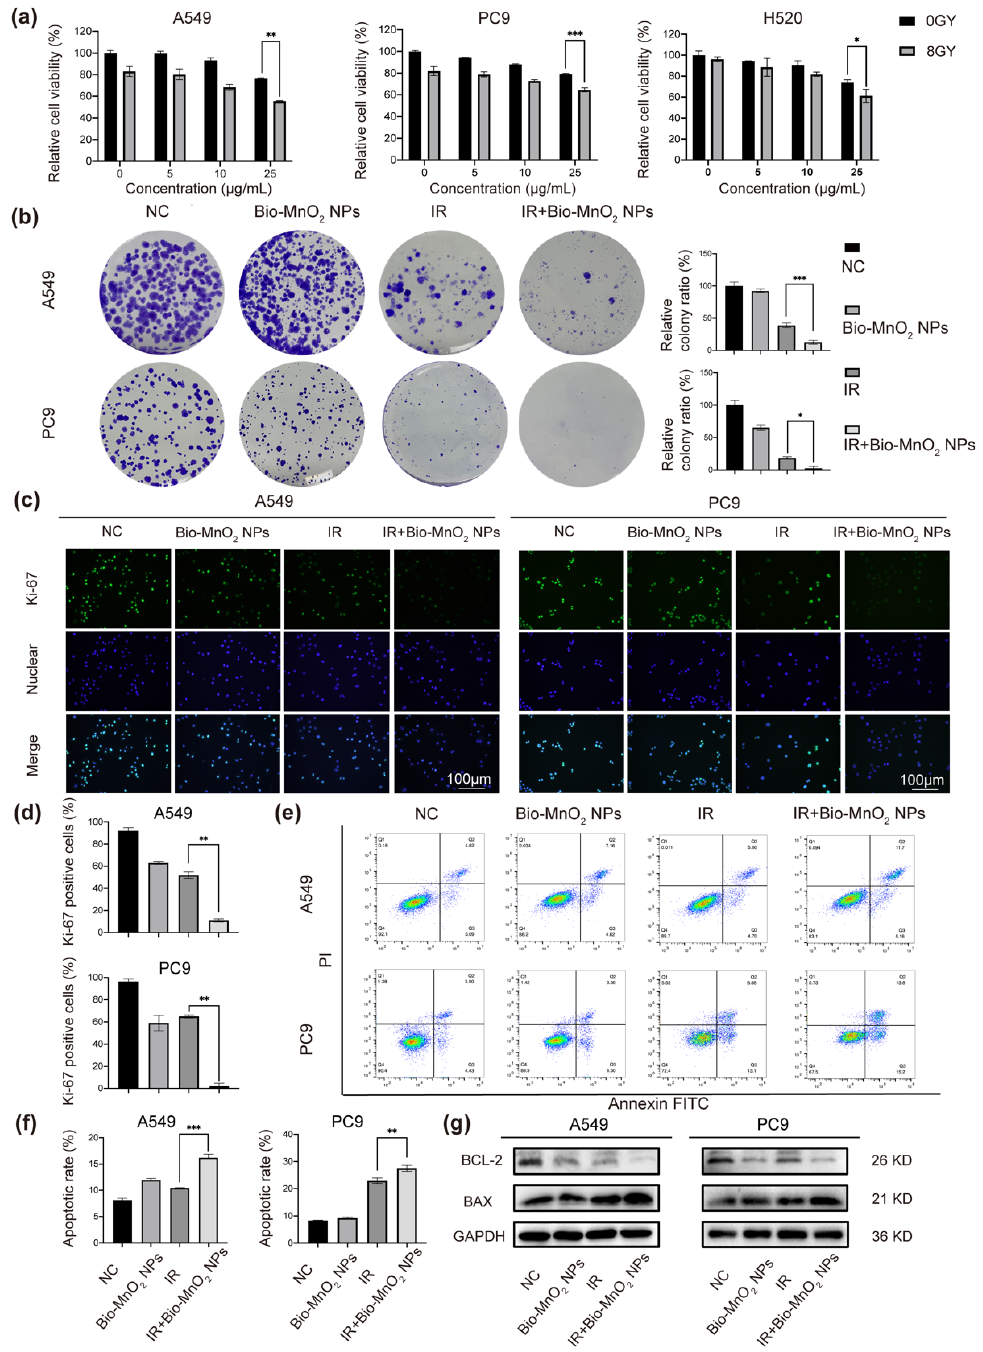
Figure 3. Bio-MnO 2 NPs enhanced radiotherapy (RT) in vitro. ( a ) Cell viabilities of A549, PC9 and H520 cells incubated with Bio-MnO 2 NPs at various concentrations with or without X-ray radiation. ( b ) Colony formation assay of NSCLC cells after different treatments and statistical graphs of colony formation assay. ( c , d ) Representative images and statistical graphs of Ki-67 immunofluorescence. Scale bar, 100 μm. ( e , f ) Cell apoptosis assay via flow cytometry. ( g ) Immunoblotting of cell apoptosis related proteins. *, p < 0.05; **, p < 0.01; ***, p < 0.001.